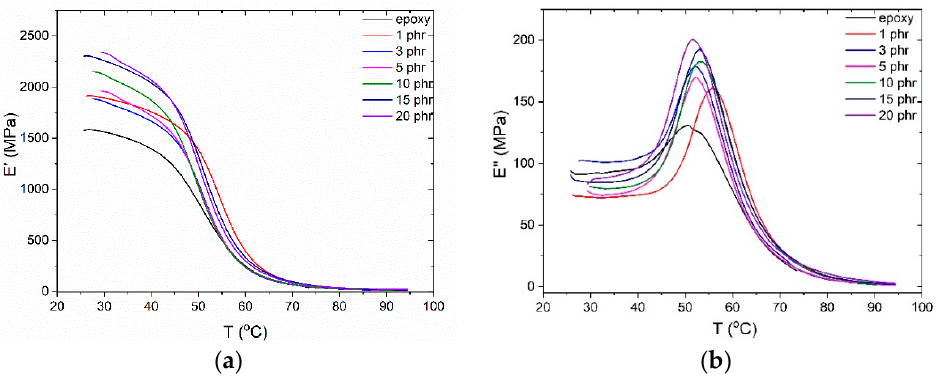
Figure 4. ( a ) Storage modulus and ( b ) loss modulus as a function of temperature, for all nanocomposites with ZnFe 2 O 4 content.